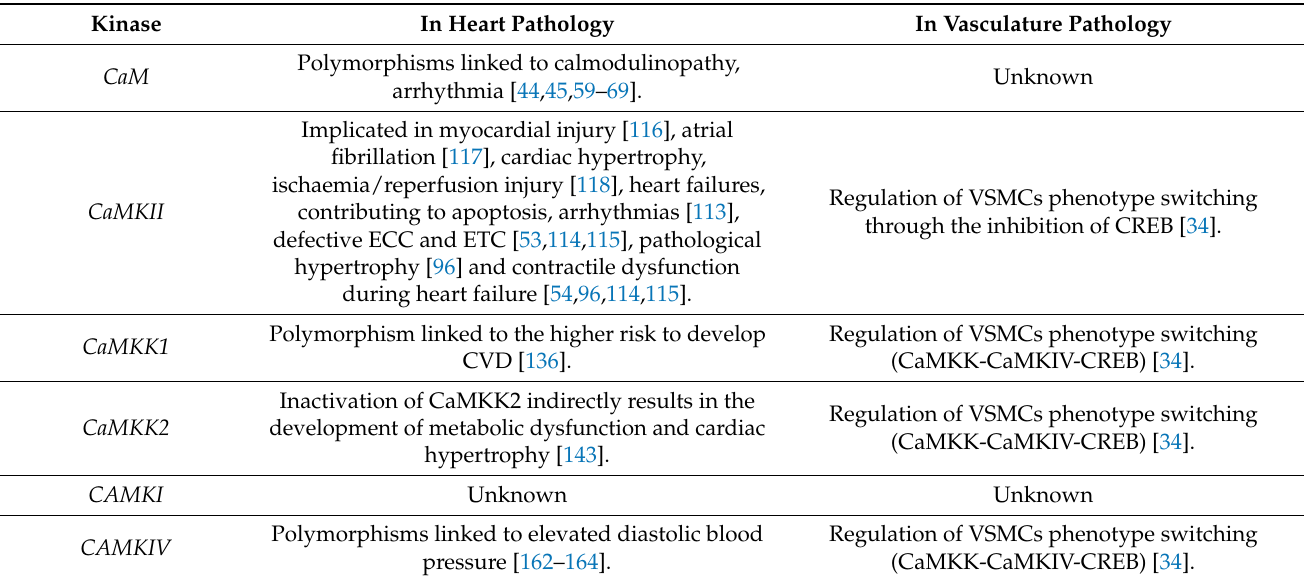
Table 2. Summary of the involvement of the CaM cascade in cardiovascular disease.